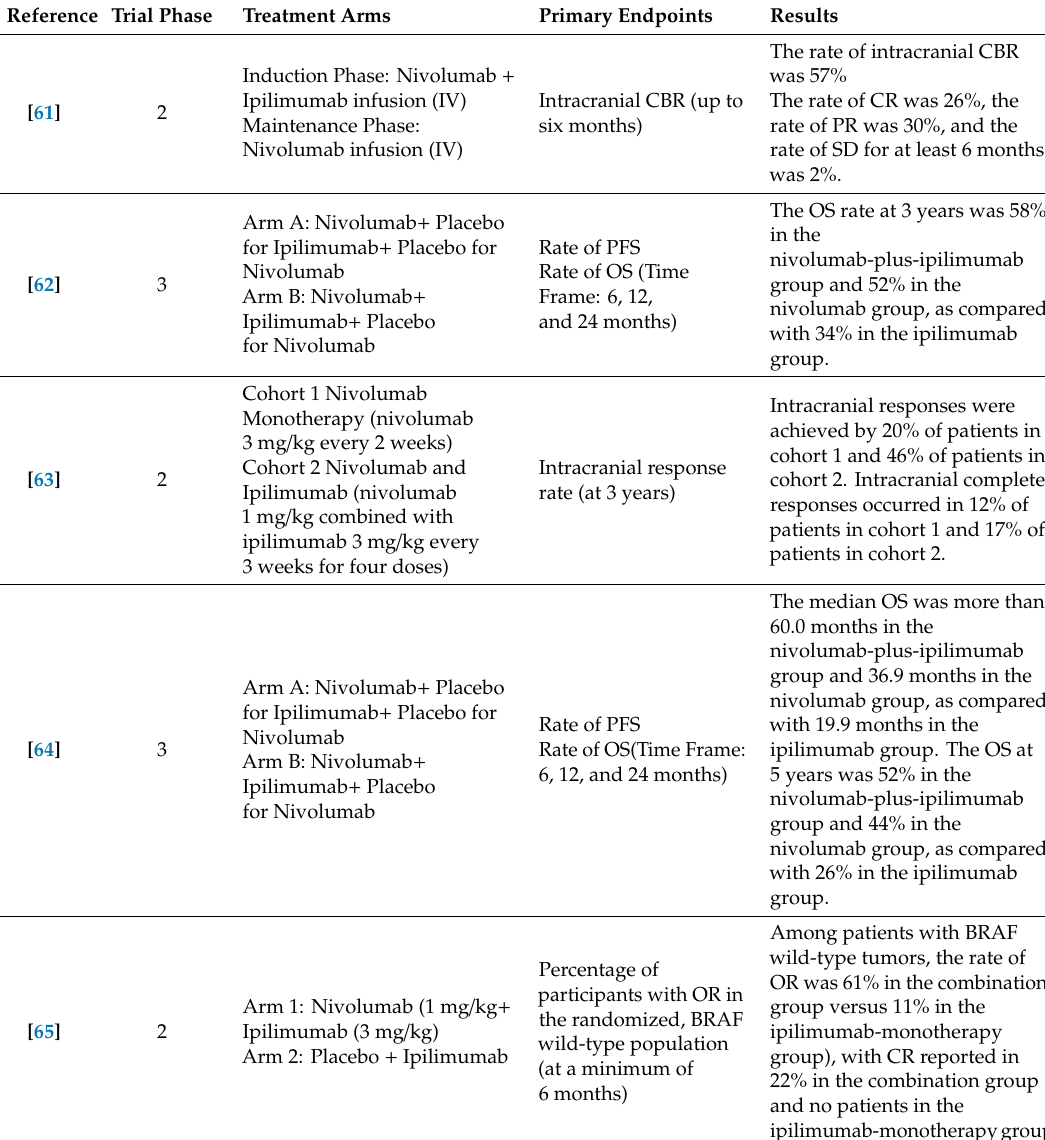
Table 1. Summary of completed (until January 2020) clinical trials of ipilimumab plus nivolumab in unresectable or metastatic